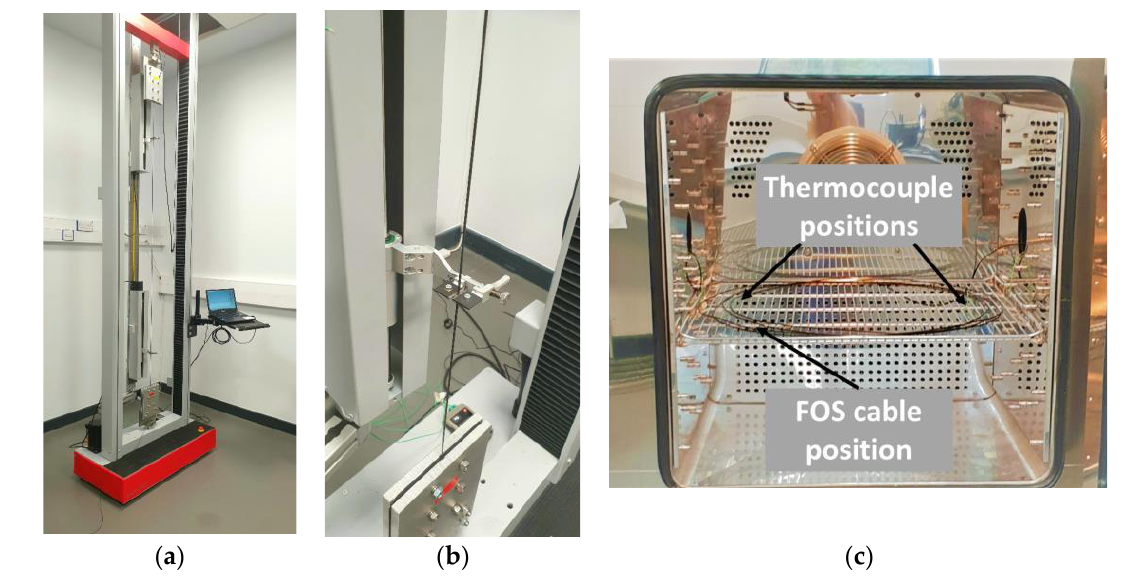
Figure 2. Photo of ( a ) overview of tensile test set-up and ( b ) plate grip and extensometer clips and ( c ) environmental chamber with indicated positions of the thermocouples.